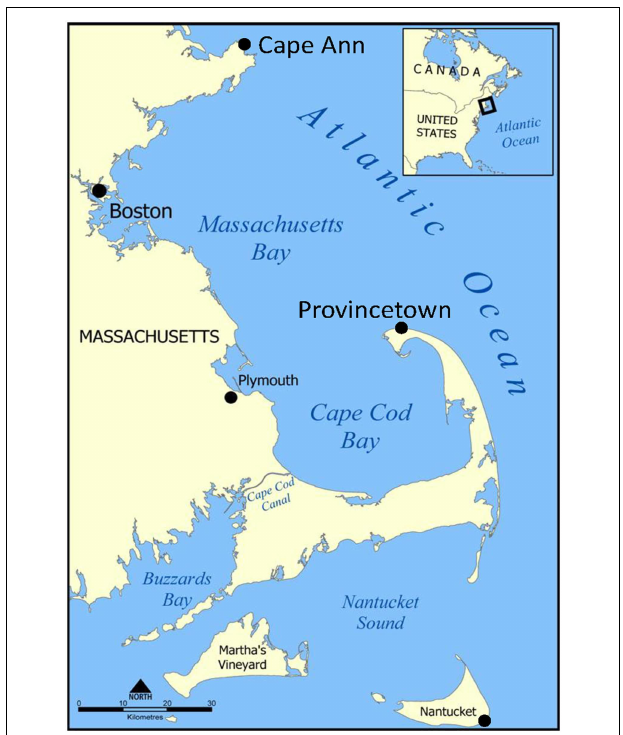
FIGURE 2 | Map of the study area showing the three main census locations: Cape Ann, Provincetown (outer Cape Cod), and Nantucket.